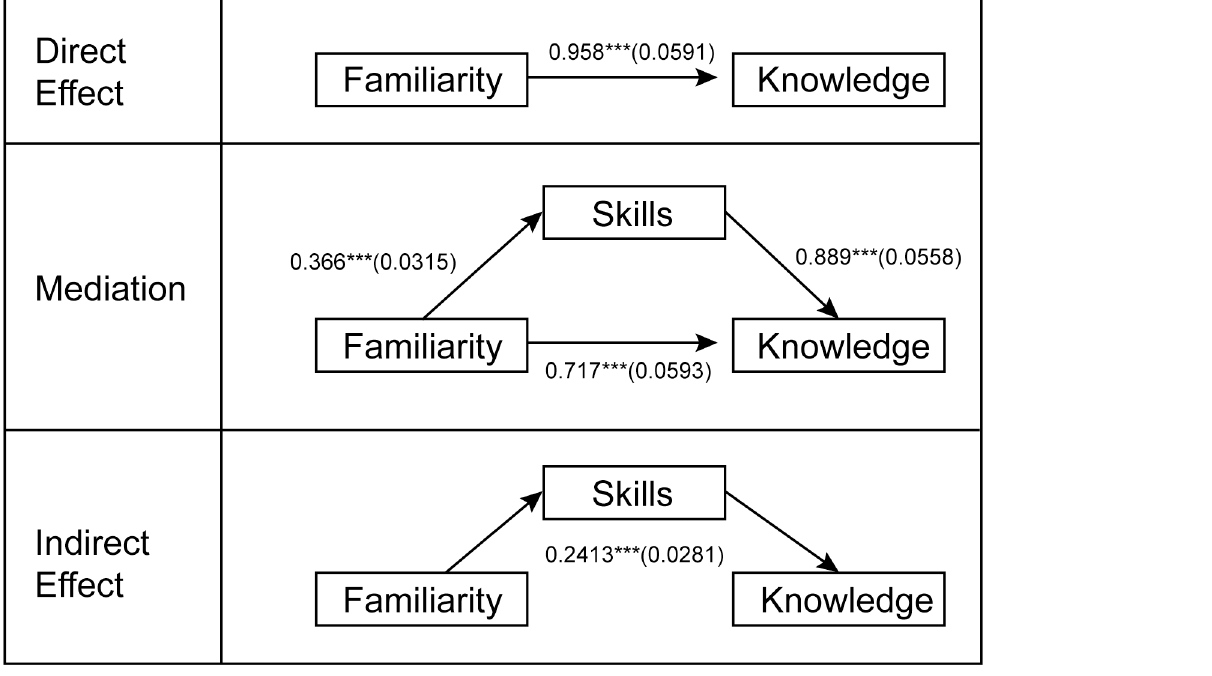
Fig 2. Mediation Model. Showing effect size (standard deviation); adjusting for education; * p < 0.05. ** p = 0.01, *** p < 0.001.